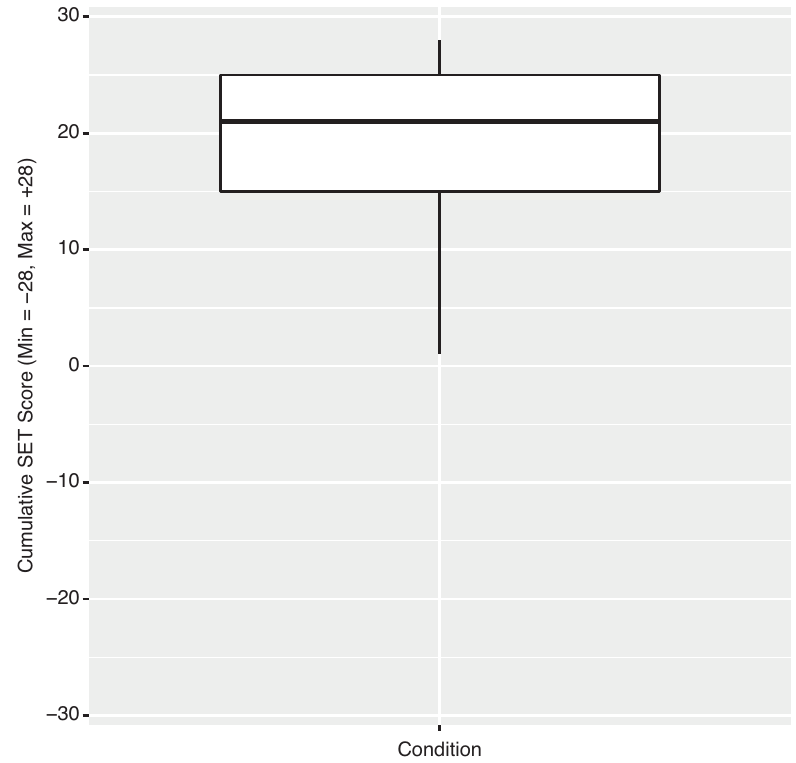
Figure 3. The boxplot of Khazan et al.’s recovered cumulative SET scores with the six outliers